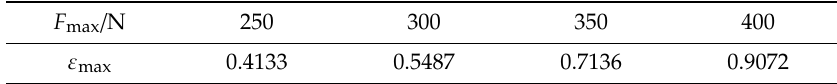
Table 1. The maximum principal strains of the hourglass specimen loaded with di ff erent maximum